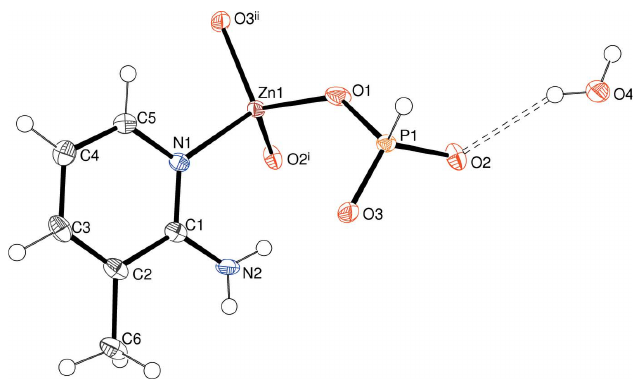
Figure 1 The asymmetric unit of (I) expanded to show the complete zinc-atom